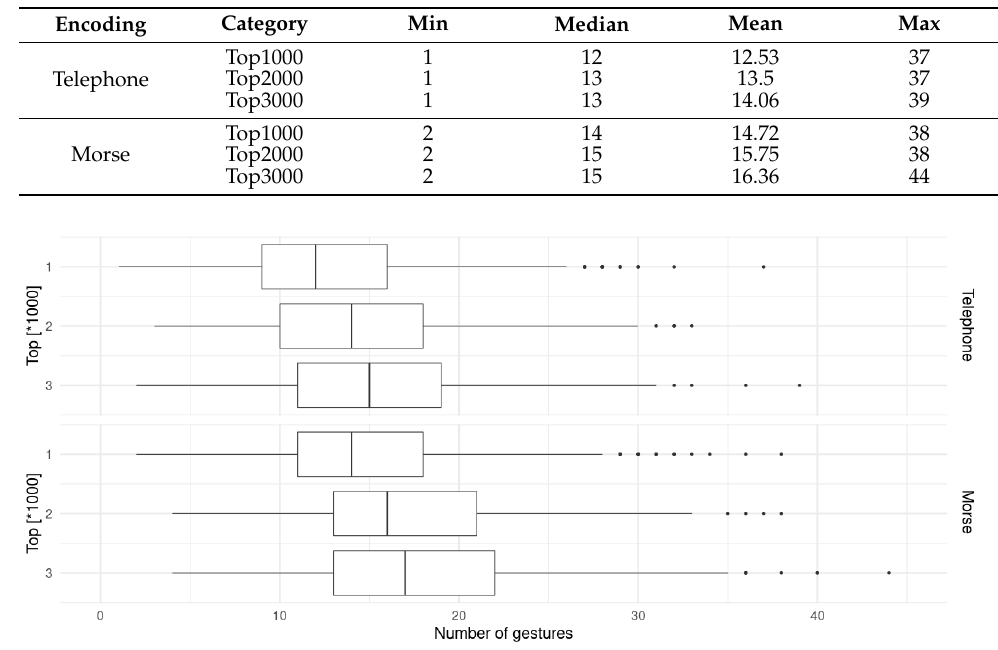
Figure 13. Graphical summary of number of gestures needed for telephone-encoded words ( top ) and morse-encoded words ( bottom